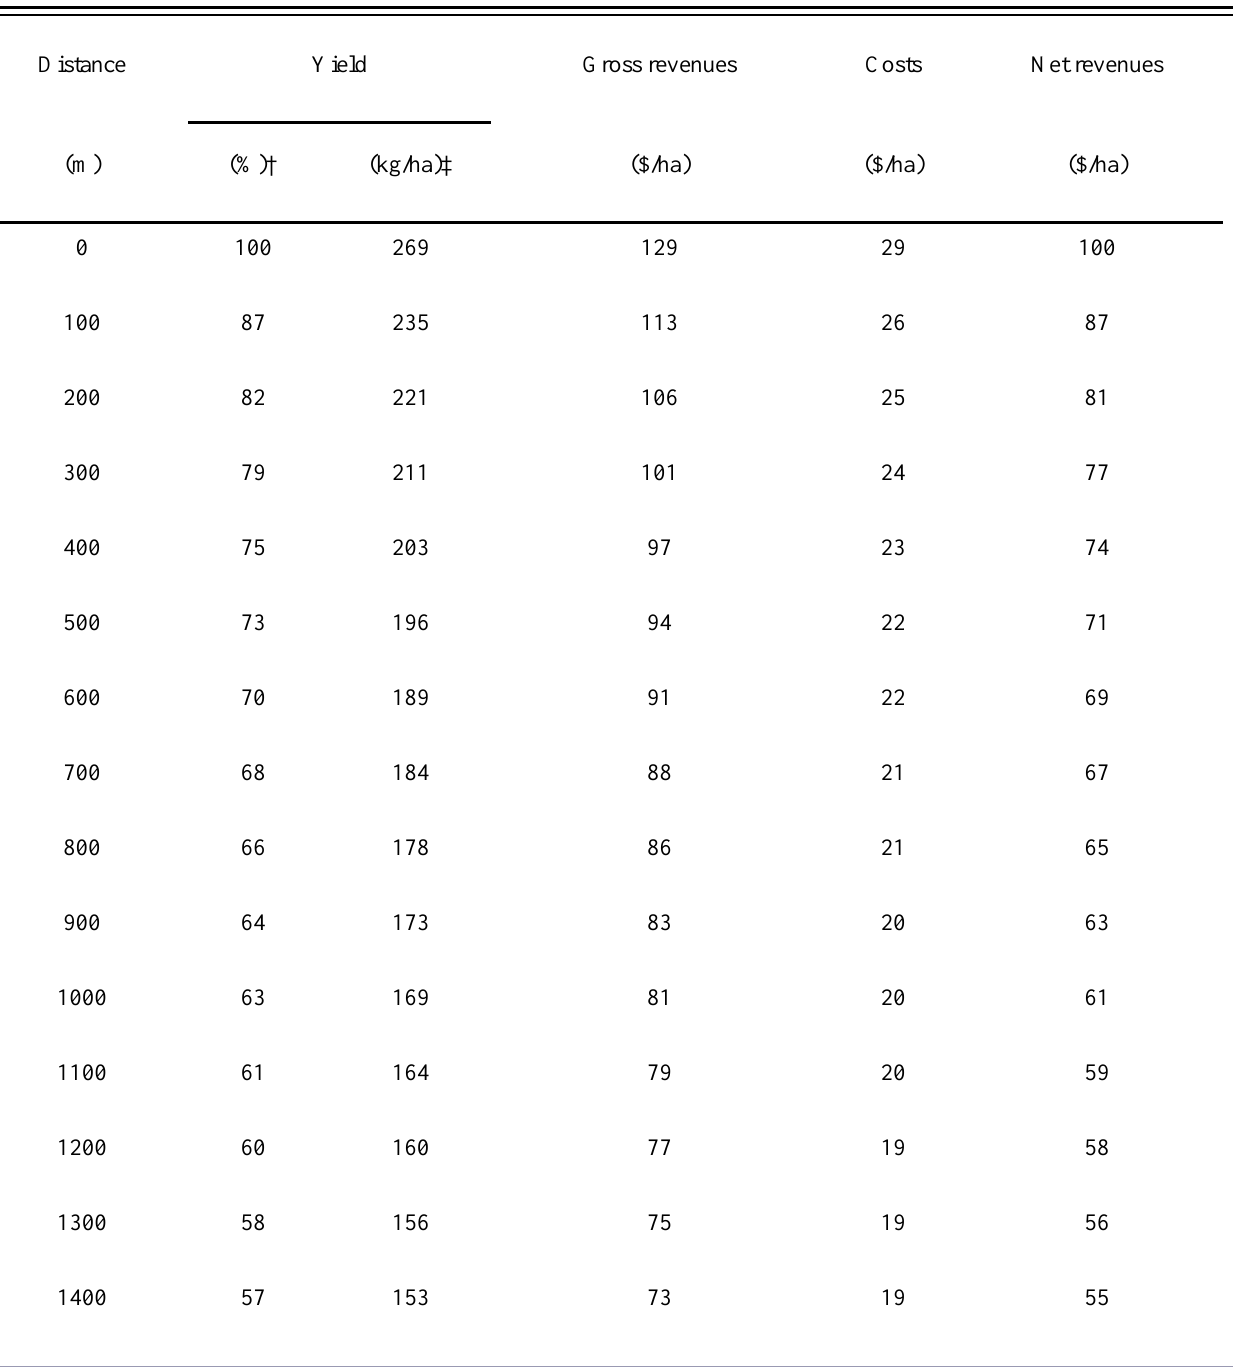
Table 1. Yield and net revenues of coffee systems in Indonesia depending on the distance to adjacent forest patches. All monetary values are in